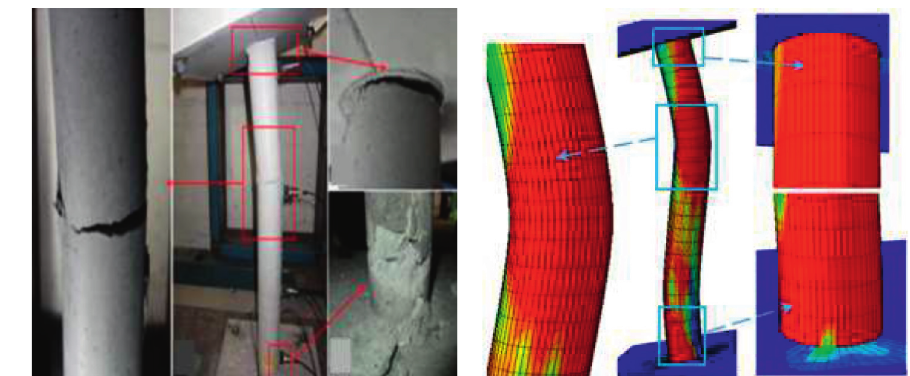
Figure 11: Comparison of damage modes at